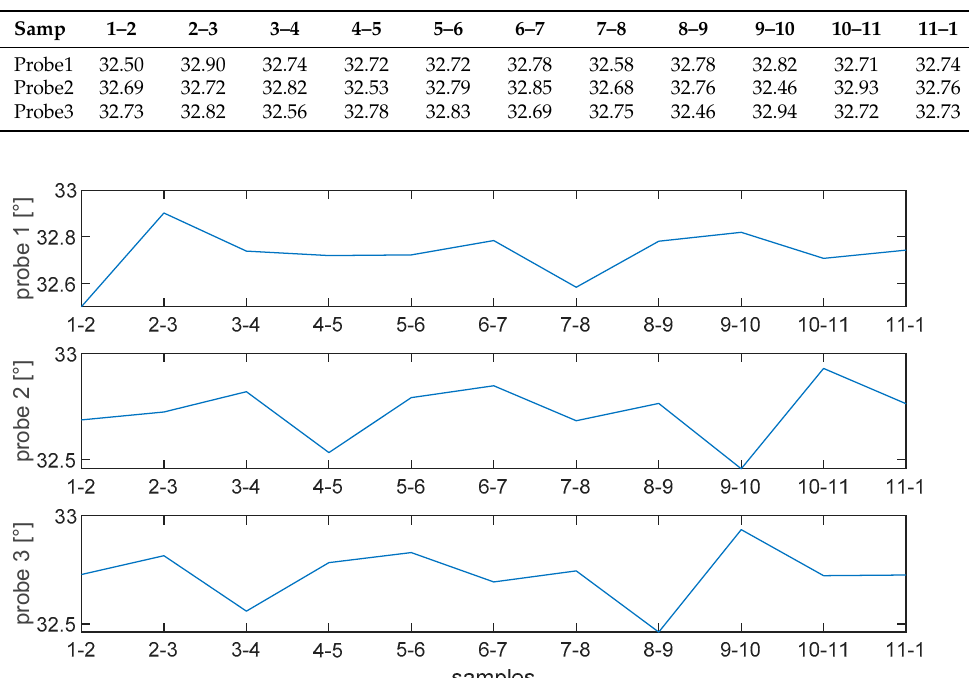
Table 2. Precise angle (°) between consecutive blades estimated from the three different probes. The minimum estimate accuracy is ±0.07 °. The ideal would be 360°/𝑀 = 32.727 °